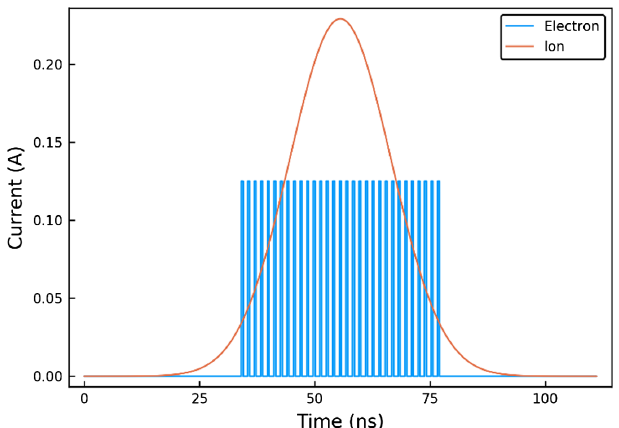
FIG. 2. Time structure of the ion and electron beam. Electrons, 50 pC per bunch and the full bunch length of 0.4 ns (uniform); ions, 6.3 nC per bunch and rms bunch length of 12 ns.